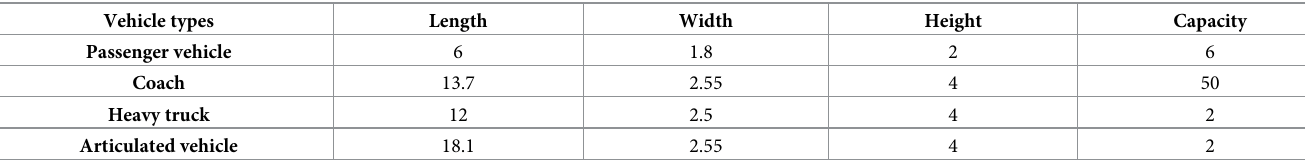
Table 2. The outline dimensions and capacity of different vehicle